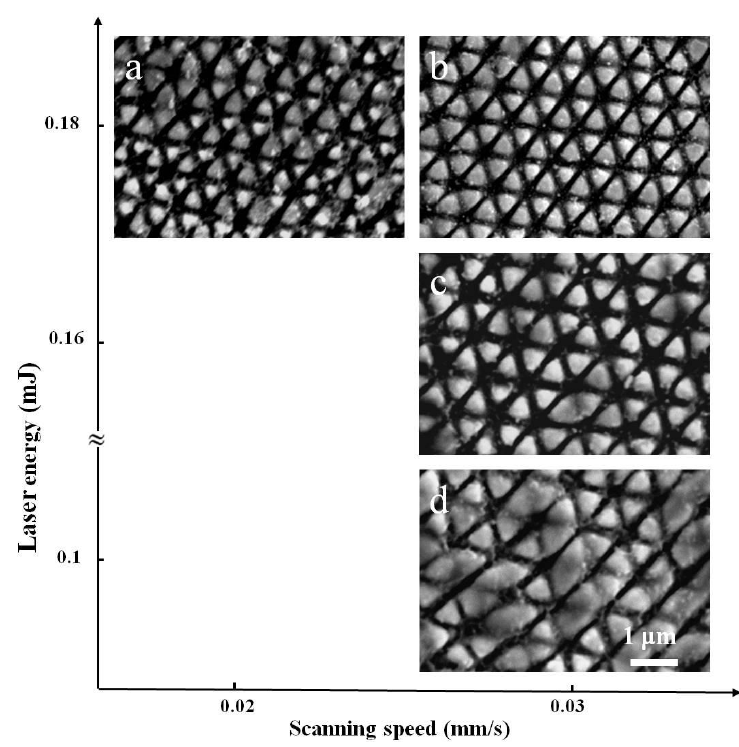
Figure 3. ( a ) represents the results under the sanning speed of v = 0.02 mm/s and the energy of E = 0.18 mJ; ( b ) for the conditions of v = 0.03 mm/s and E = 0.18 mJ; ( c ) for the conditions of v = 0.03 mm/s and E = 0.16 mJ; ( d ) for the conditions of v = 0.03 mm/s and E = 0.1 mJ. Materials 2018 , 11 , x